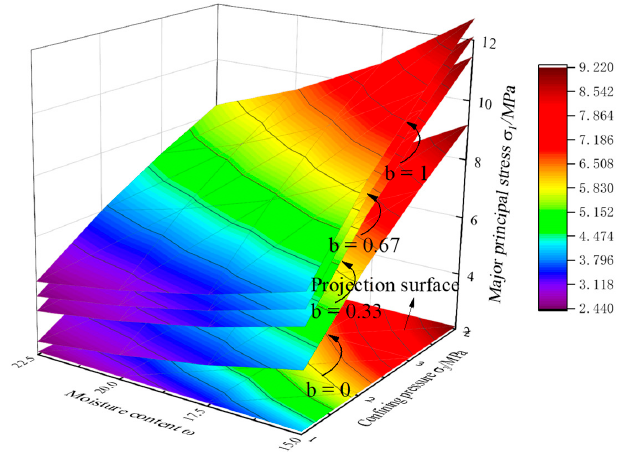
Figure 6. Three-dimensional trend chart of confining pressure, water content, and major principal stress under different b values.